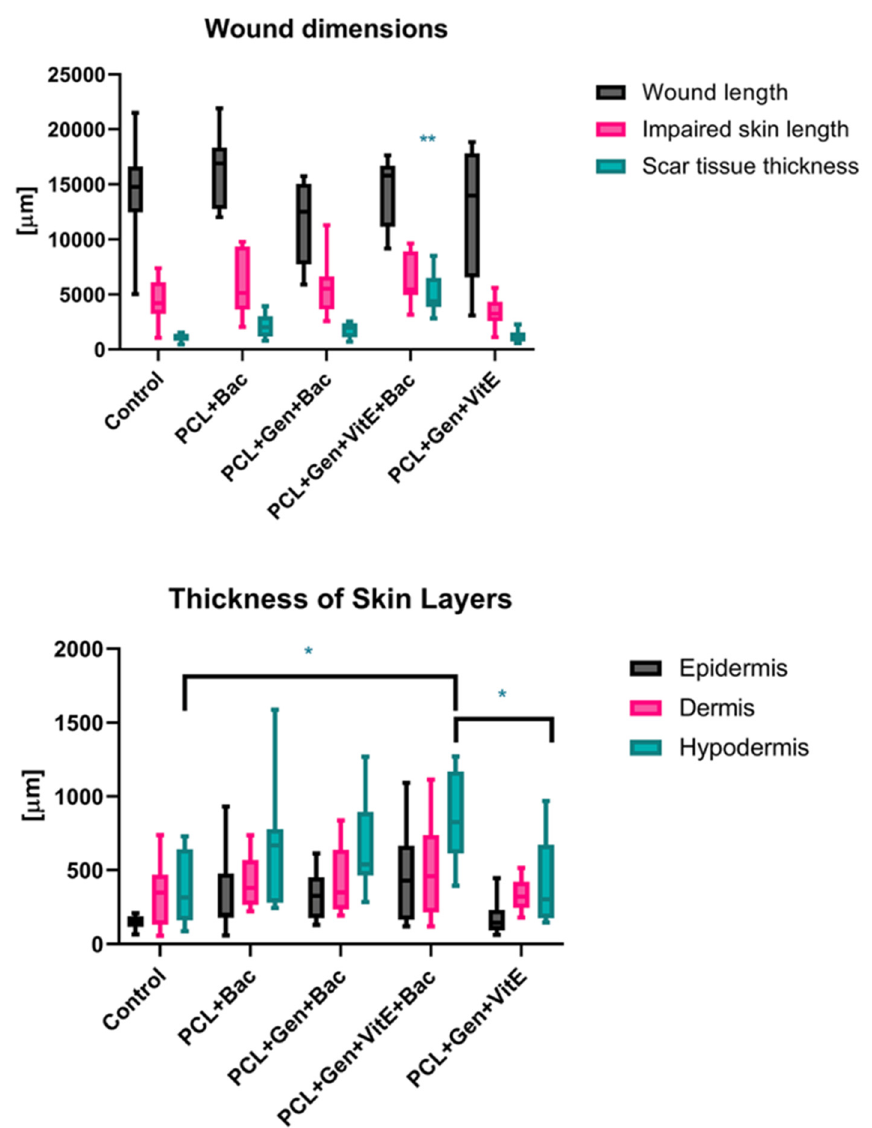
Figure 12. Histological evaluation of newly formed tissue according to Table 2. Defects treated with PCL nanofibers (PCL), gentamicin (Gen), α -tocopherol acetate (VitE), and infected by S. aureus and P. aeruginosa (Bac) or untreated defects (control). Significant difference * p < 0.05, ** p < 0.01.